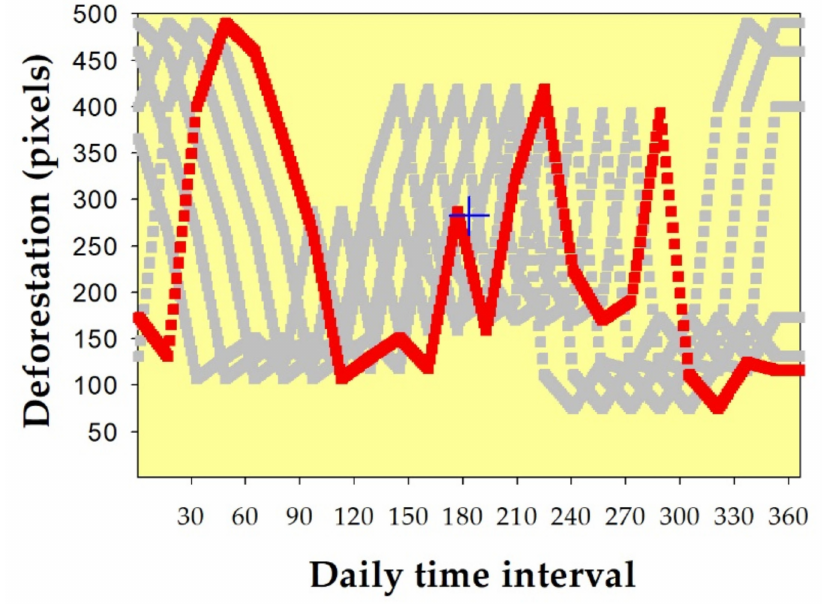
Figure 21. Interpolated hypothetical deforestation time-series data shown in Figure 7 at a time slice of a 1-day interval. Red squares indicate the original time-series; grey squares indicate left shifts from the original, representing an acceleration on detection from 16 days to 80 days. The blue cross is the centroid of the graph.